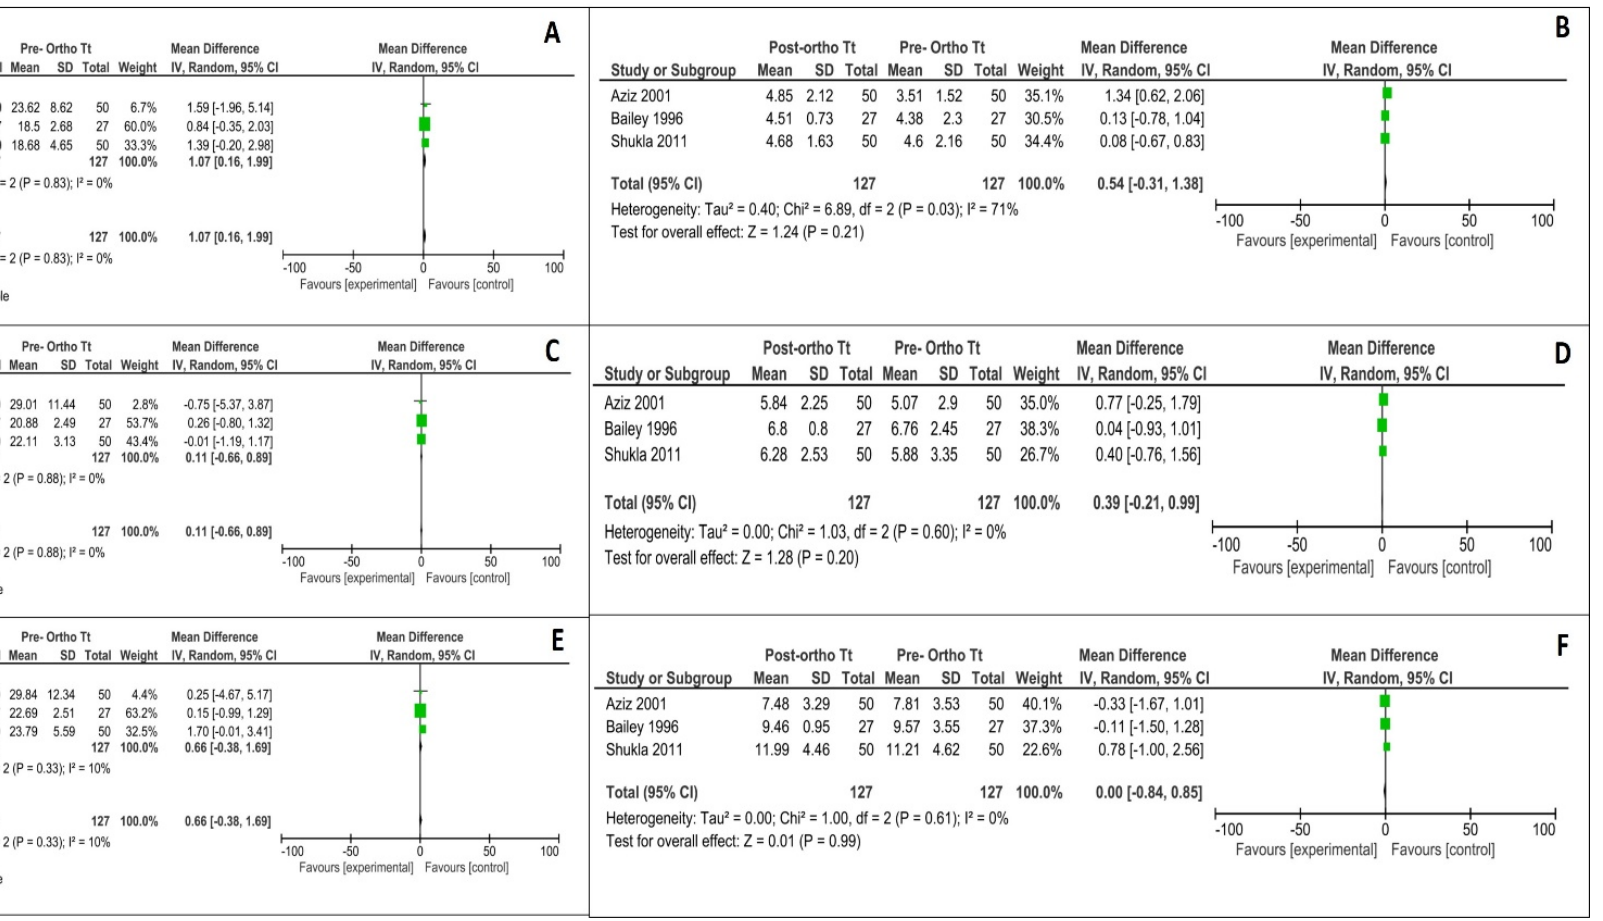
Figure 2. Meta-analysis summarizing the effect of the orthodontic treatment on the transverse dimensions. ( A ) Transverse bilateral changes in first palatal rugae (lateral); ( B ) Transverse bilateral changes in first palatal rugae (medial); ( C ) Transverse bilateral changes in second palatal rugae (lateral); ( D ) Transverse bilateral changes in second palatal rugae (medial); ( E ) Transverse bilateral changes in third palatal rugae (lateral); ( F ) Transverse bilateral changes in third palatal rugae (medial).